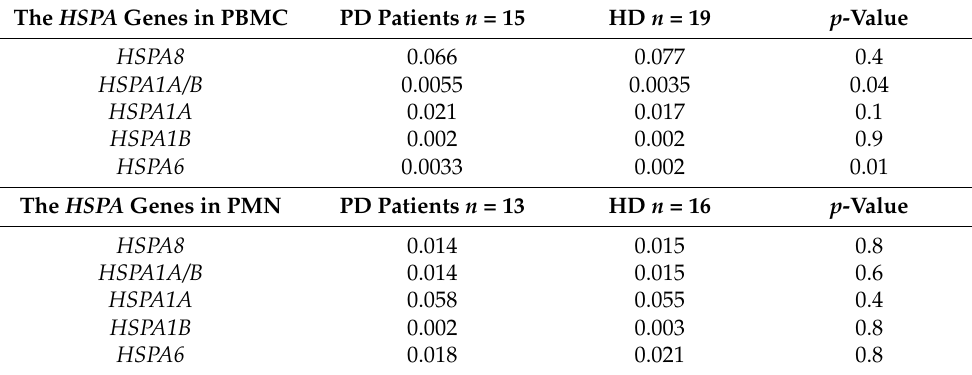
Table 2. Normalized mRNA levels of HSPA genes (medians) in PBMC and PMN in PD patients compared to HDs. The HSPA Genes in PBMC PD Patients n = 15 HD n = 19 p -Value